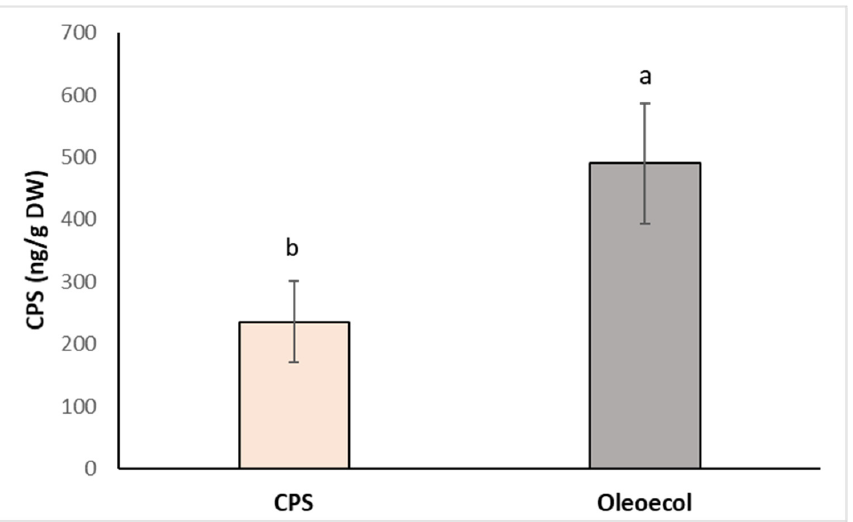
Figure 6. Concentration of CPS in the roots of alder sprayed with 0.750 mL solution of CPS (3 mg L − 1 ) or the insecticide Oleoecol (0.750 mL) at the producer’s recommended concentration. Samples were collected 10 days after foliage application. Different letters mean statistically significant differences ( p ≤ 0.05).